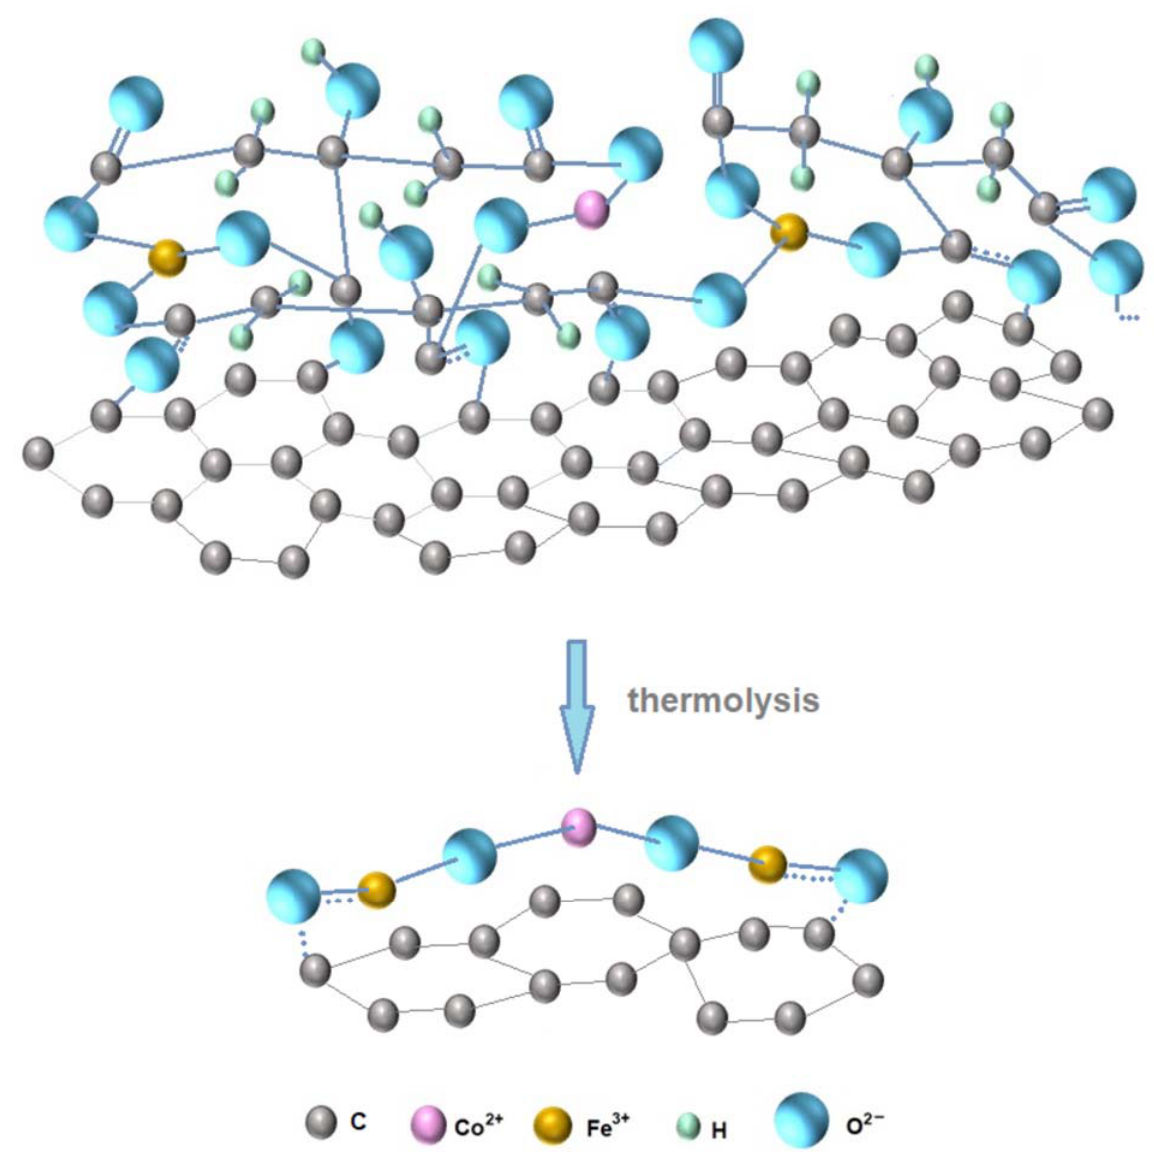
Figure 5. Possible structure of the intermediate citrate complex of transition elements.